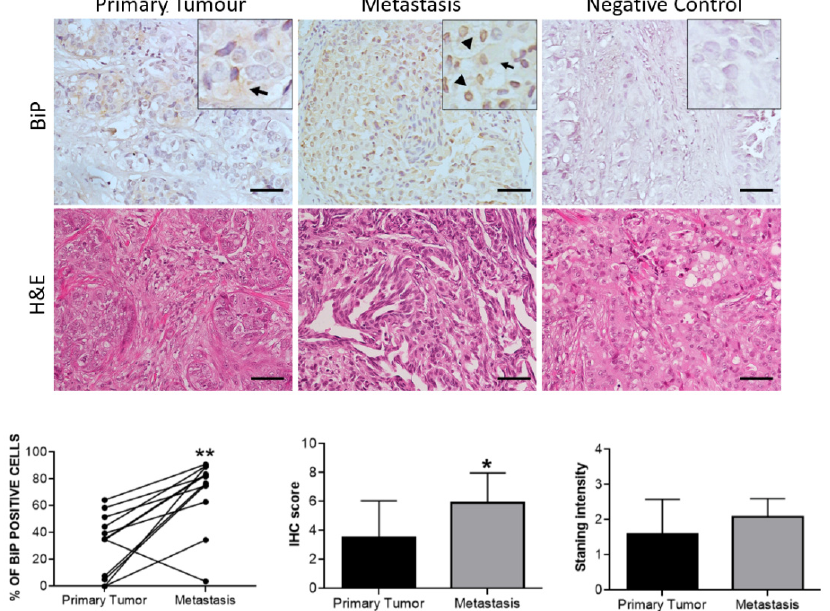
Figure 8. Representative pictures of BiP immunostaining and respective H&E in treatment-naïve primary tumors vs. their paired metastasis. Arrows indicate cytosolic BiP expression while arrow- heads show BiP nuclear localization in neoplastic cells. All pictures were from the same invasive ductal carcinoma case, as seen in the corresponding H&E slide showing irregular ducts infiltrating the breast stroma. Scale bars: 50 μ m. The bar graphs comparing %BiP positive cells, BiP IHC score, and BiP IHC intensity of staining in paired treatment untreated tumors vs. post-treatment metastases ( n = 12). *: p < 0.05, **: p < 0.01; Wilcoxon paired test. Table 9. Correlation between BiP expression and the clinicopathological factors in cohort 2. Clinical Factor